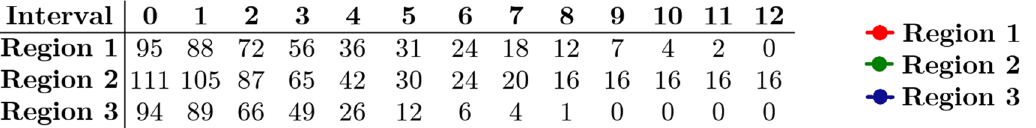
Figure 3. For various time intervals ( a ) total waste in CV and ( b ) average waste left in bins. Effect of no. of CV on ( c ) total collected waste collected and ( d ) total distance travelled; after applying the restriction on the resources for all the three